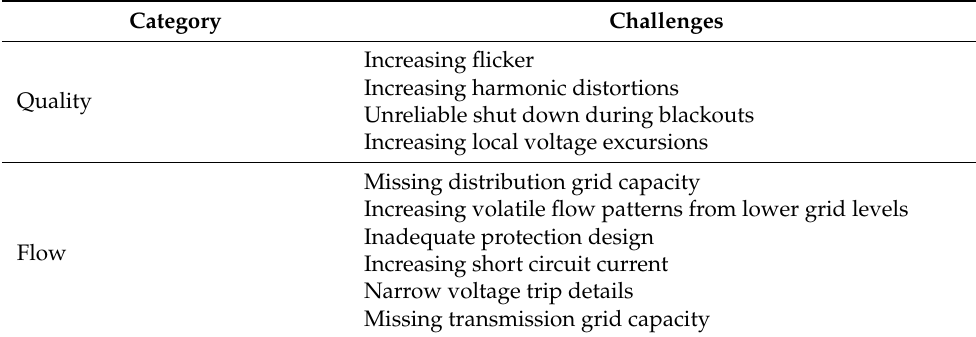
Table 6. Challenges of RES integration to grid